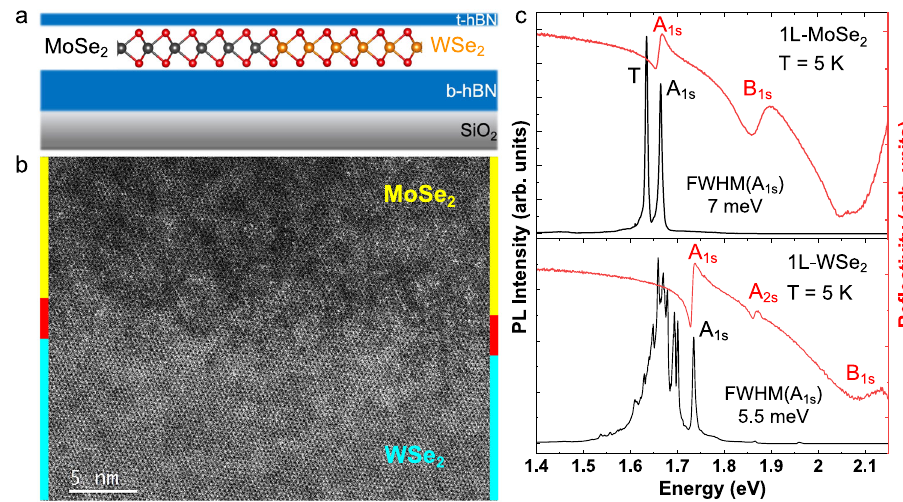
Fig. 1 Lateral heterostructure spectroscopy and microscopy. a Schematic representation of the MoSe 2 -WSe 2 LH, encapsulated in hBN. Grey, orange and red spheres represent Mo, W and Se atoms, respectively. b HAADF-STEM image showing a MoSe 2 -WSe 2 boundary (between the red lines). The MoSe 2 and WSe 2 areas are located between the yellow and the cyan lines, respectively. c Corresponding PL (black) and re fl ectance contrast (red) spectra of MoSe 2 (top) and WSe 2 (bottom). The PL linewidth of neutral excitons (A 1 s ) is 7 meV in MoSe 2 and 5.5 meV in WSe 2